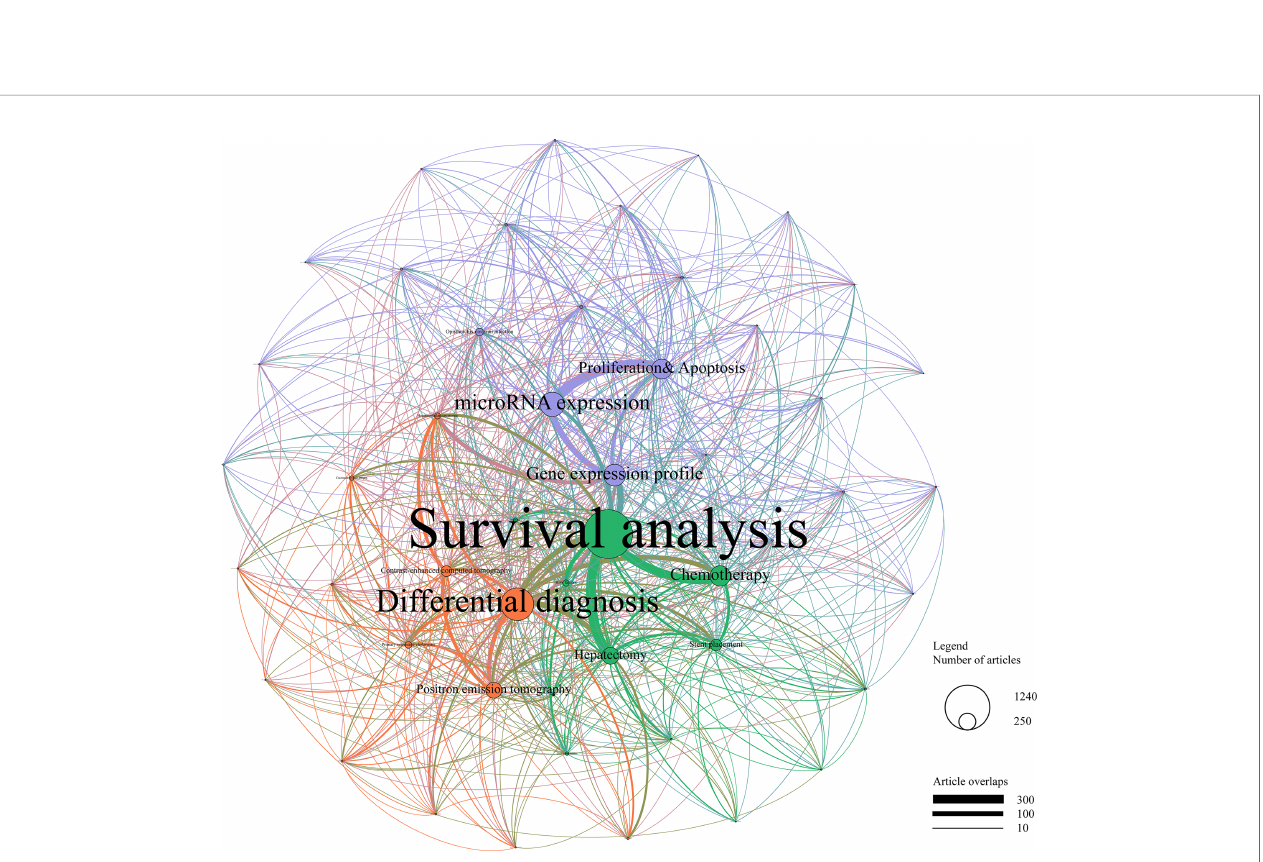
FIGURE 5 | Topic cluster network by latent Dirichlet allocation. Green, treatment management; red, diagnosis research; purple, basic research. The size of the circle represents the number of papers in each topic, and the thickness of the line represents the weight of connection between each